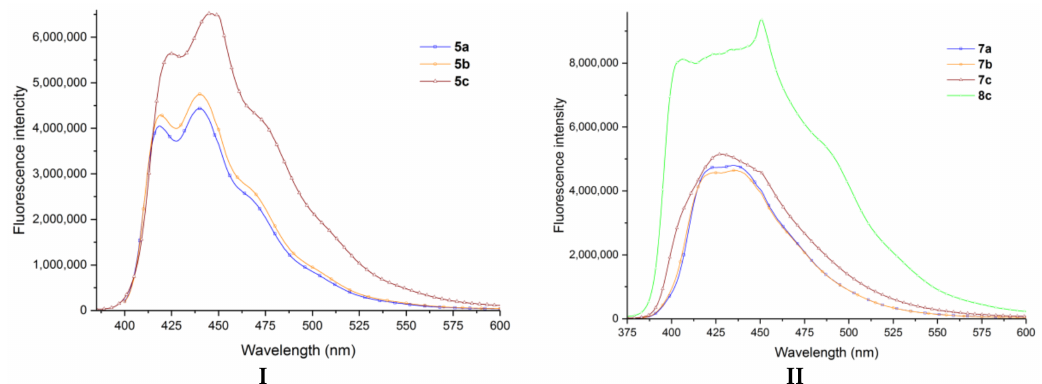
Figure 4. The emission spectra recorded in trichloromethane solution of the azasteroid derivatives: ( I )- 5a – c ; ( II )- 7a – c and 8c